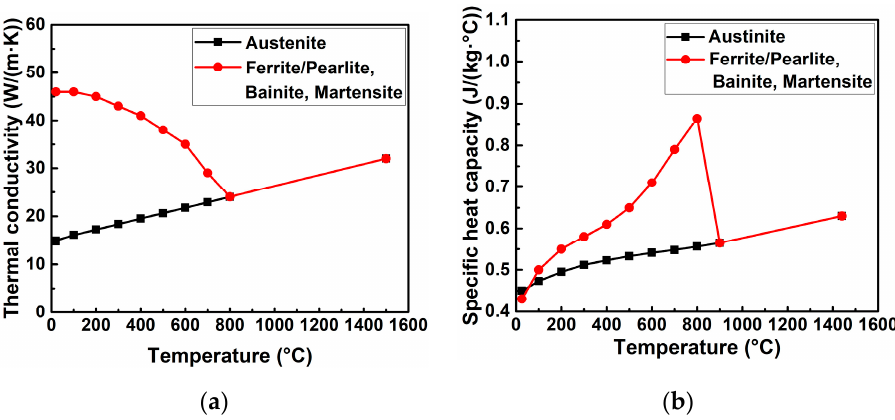
Figure 8. Temperature-dependent thermal properties of S355 steel (from [22]): ( a ) Thermal conductivity; ( b ) specific heat capacity.